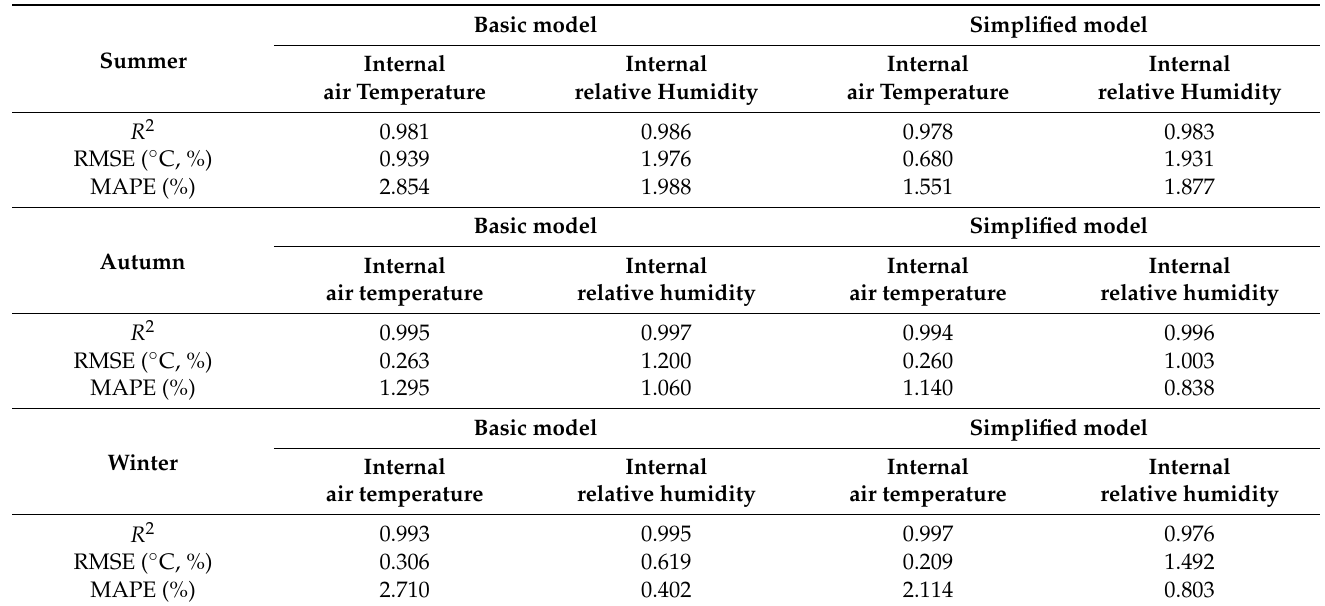
Table 7. Accuracy of RNN model of naturally ventilated duck house according to seasons and variables (sequential